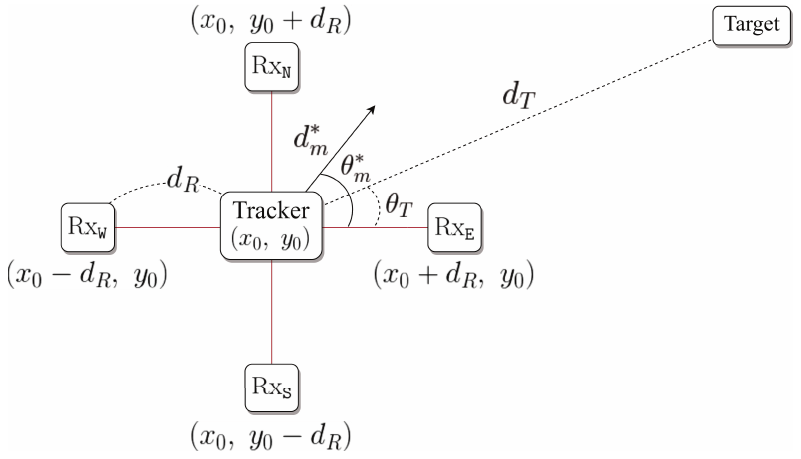
Figure 1. Tracking system